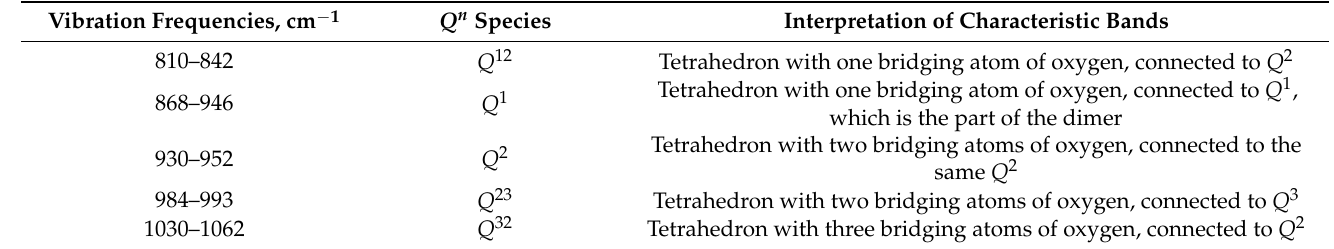
Table 3. Interpretation of characteristic bands in the Raman spectra of melts and glasses of system compositions K 2 O-SiO 2